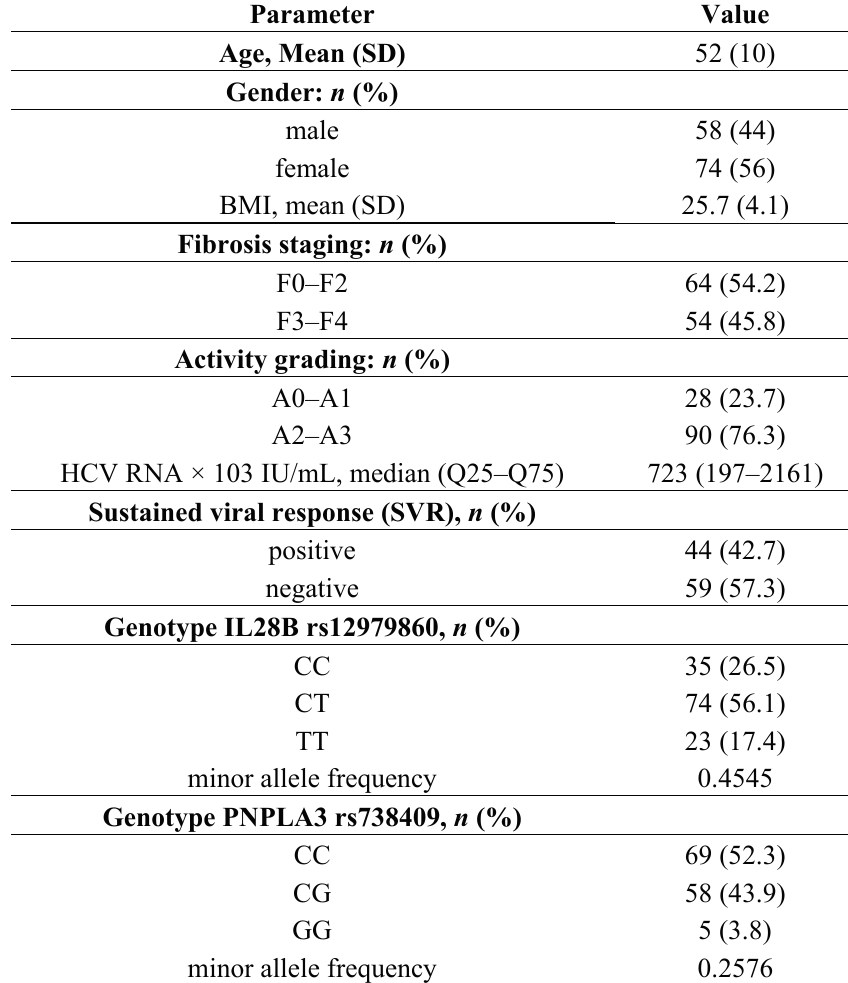
Table 1. Demographic, biological, and virological characteristics of patients.